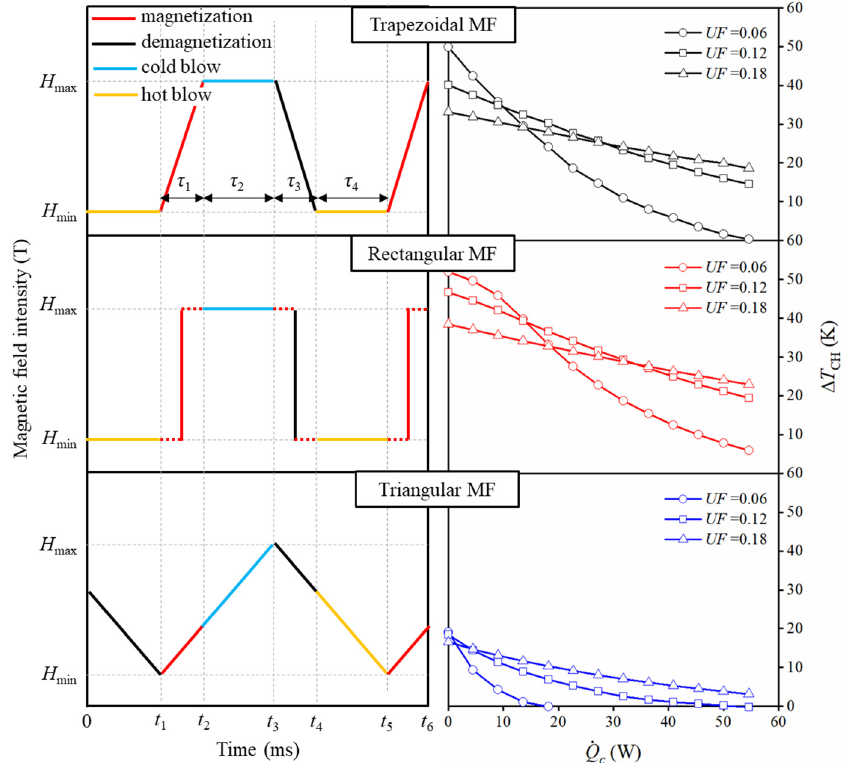
. . Q c under different UFs under different UFs